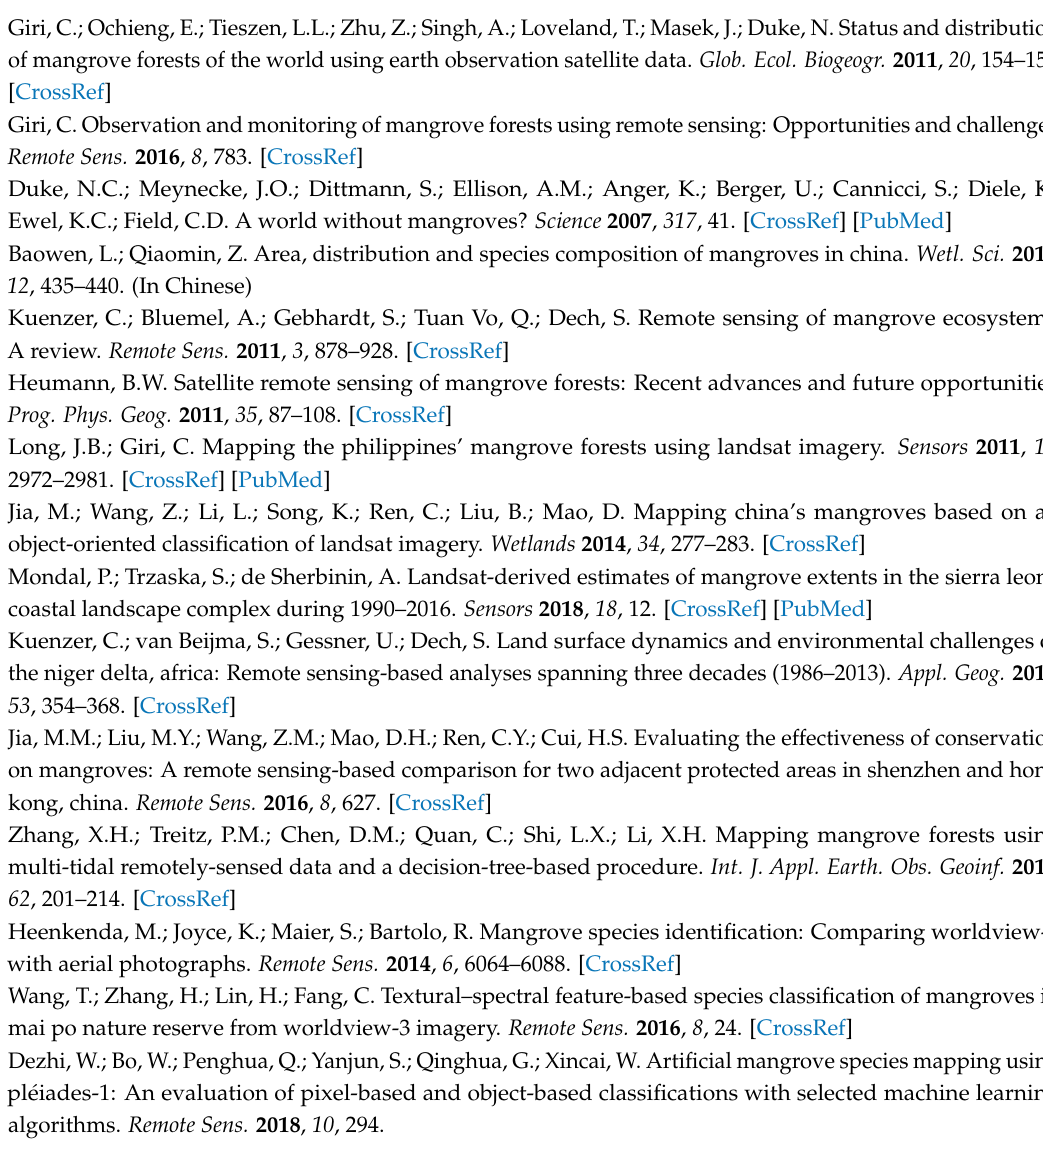
marina , and LR is L. racemos .